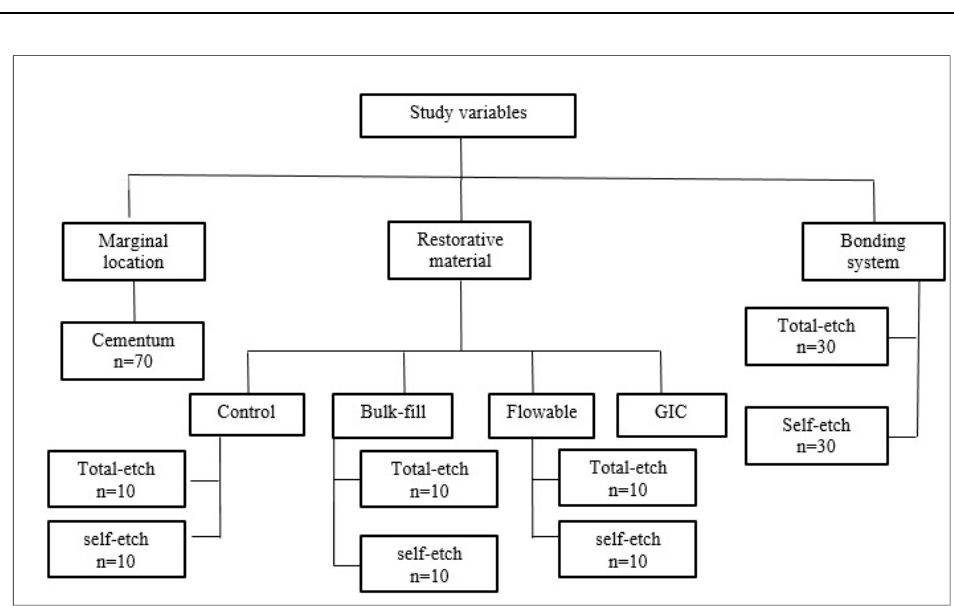
Figure 1. Schematic presentation of the study design and variables.